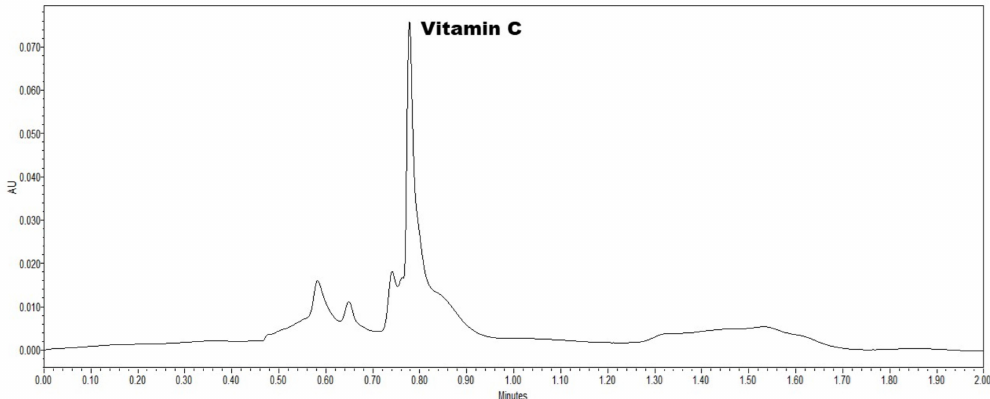
Figure A5. Chromatogram of leaves extracts obtained from habanero pepper plants grown in red